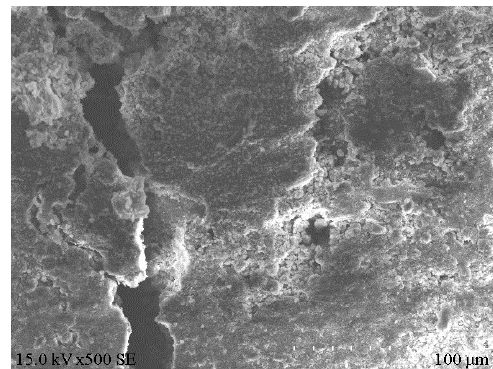
Figure 9. Microstructure of A1 samples.